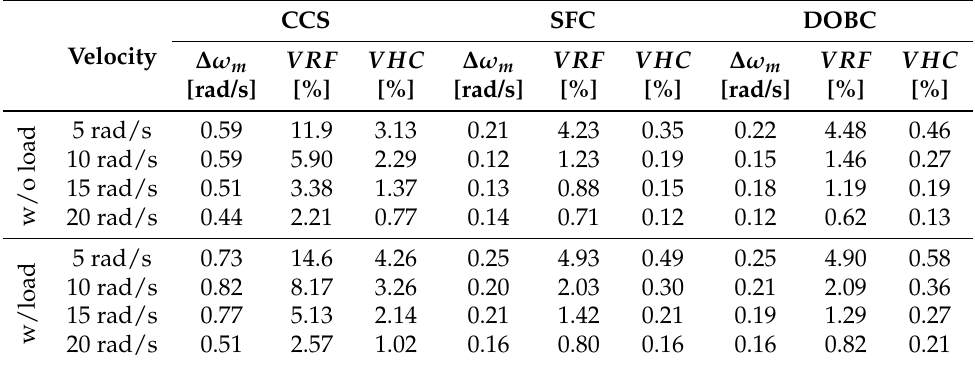
Table 4. Calculated velocity indicators for selected angular speeds.